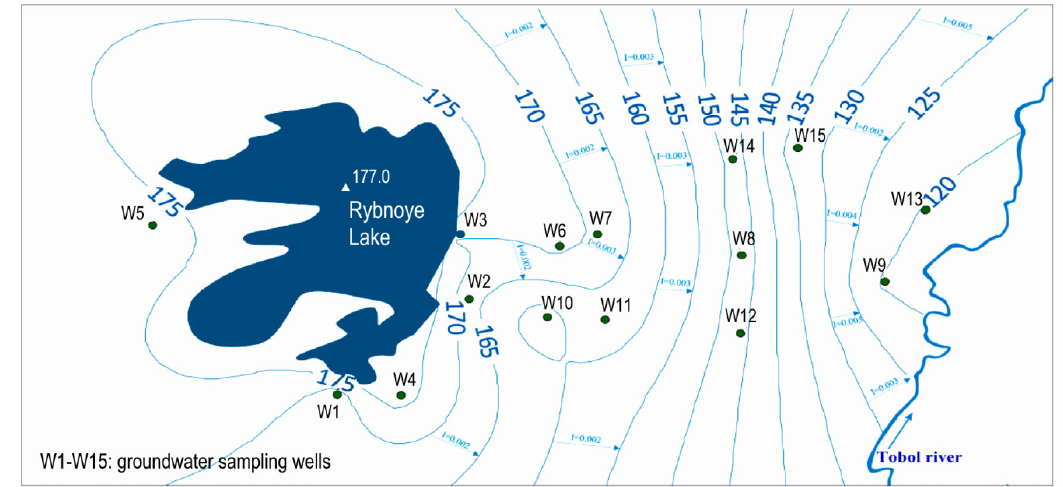
Figure 3. Isolines of groundwater level (m a.s.l.) in the study area.